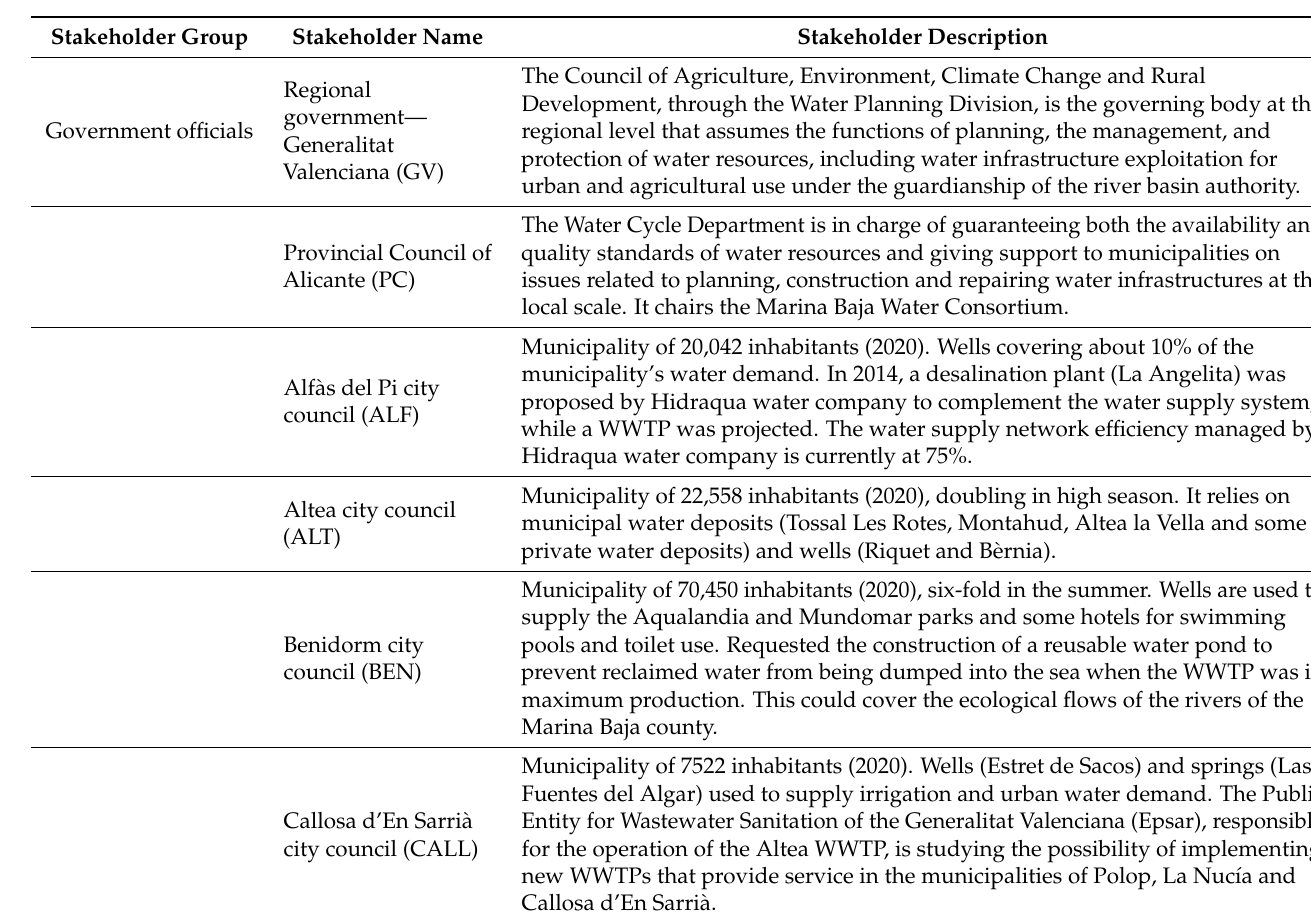
Table 1. Stakeholders listed by groups and described according to its